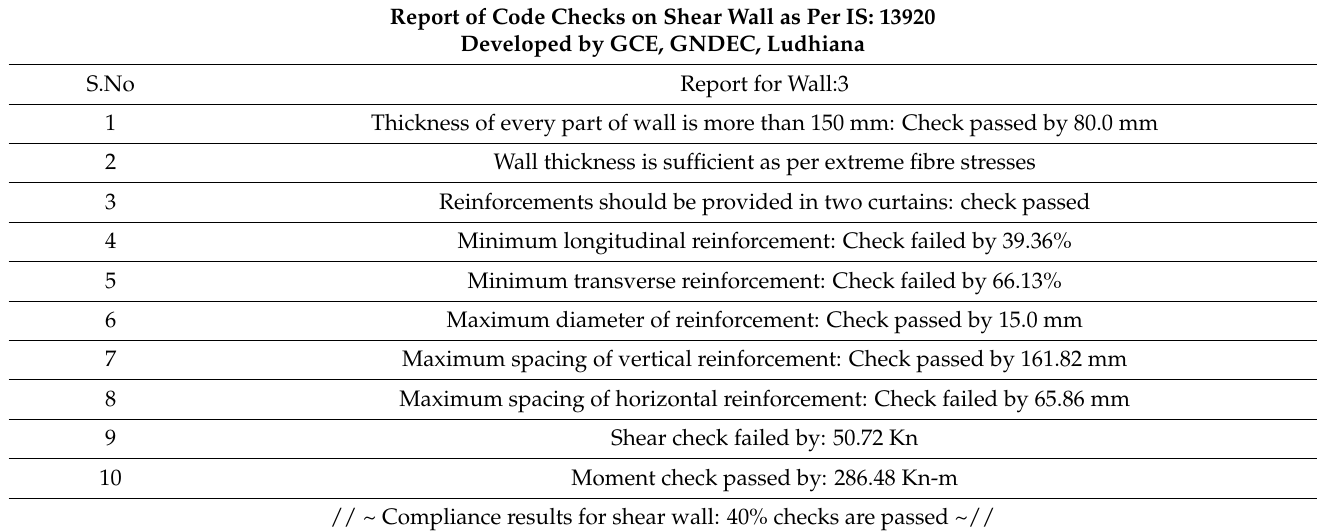
Figure 19. Percentage of automated structural design achieved. Figure 20 depicts the average run time of the research, which is compared with the other methods. The average run time for BIM-based automated modeling was compared with existing methods, such as multi-agent reinforcement learning (MARL) systems. Con- sequently, comparing this average run time with the existing method, the proposed method requires less run time and, therefore, improves the system performance.